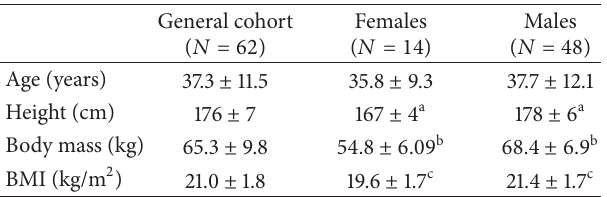
Table 1: Anthropometric characteristics of elite and recreational mountain runners participating at a qualifying for the European Championships.